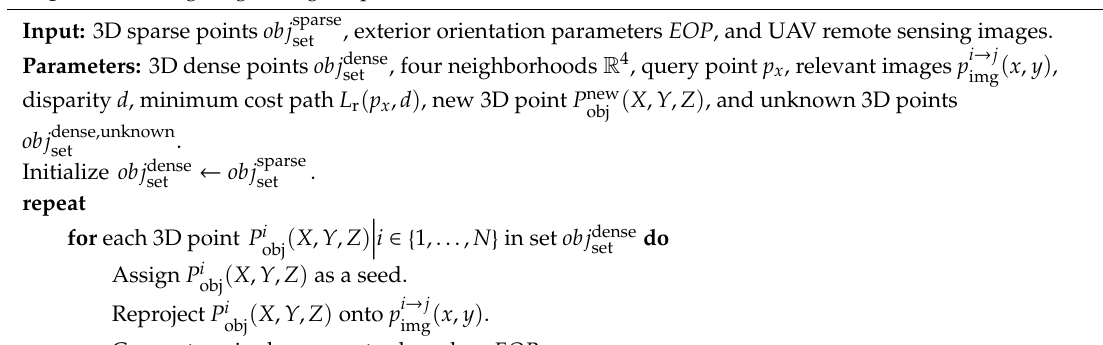
Algorithm 1: Region growing coupled with